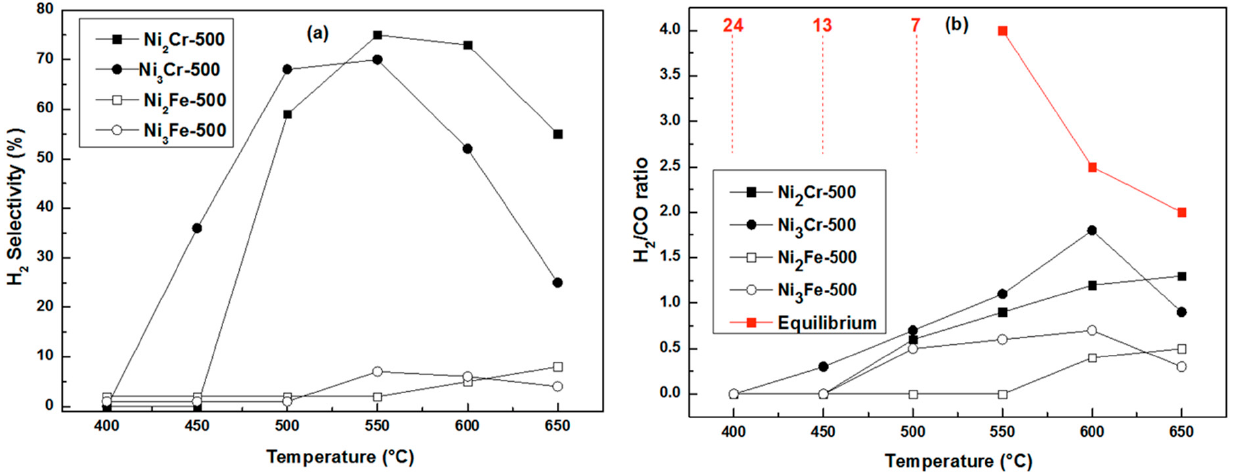
Figure 11. H 2 selectivity ( a ) and H 2 /CO ratios ( b ) obtained on the fresh Ni R M-500 (M = Cr or Fe, R = 2 or 3) catalysts issued from LDH structure and calcined at 500 °C (CH 4 = 20%; CO 2 = 20%; 100 mg; F = 100 mL/min).